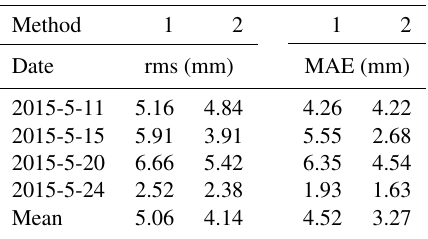
Table 3. Statistical results of SWV comparison between different tomographic methods and estimated SWV values for the selected 4